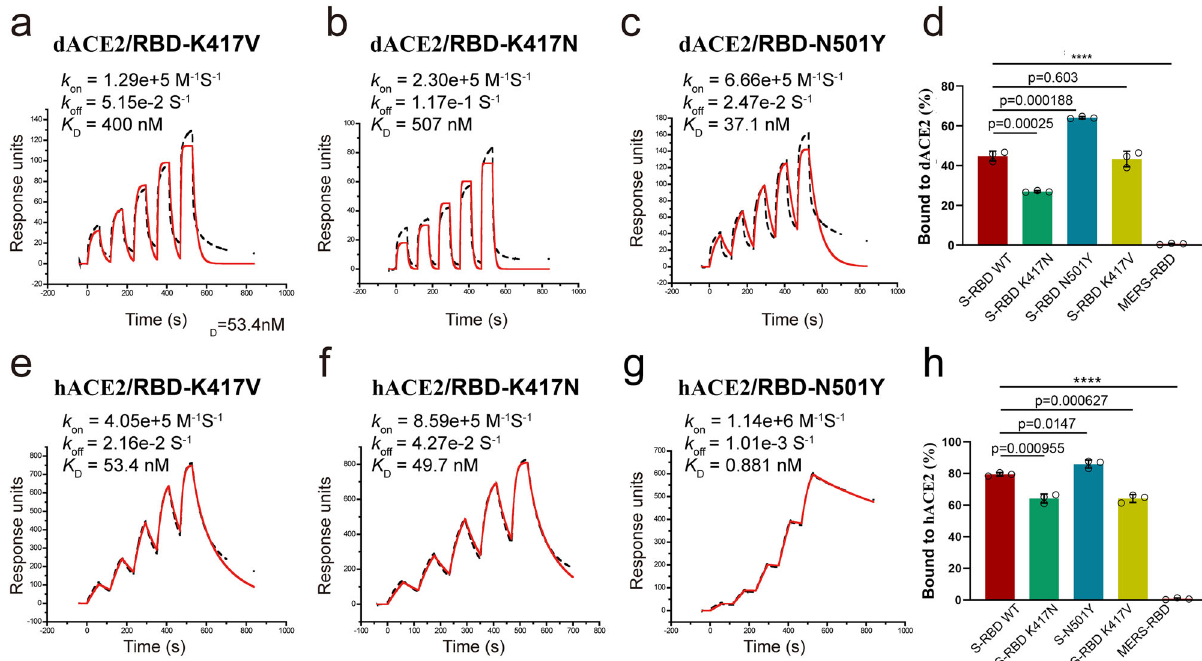
Fig. 4 The binding ability of RBD mutants to both soluble and transmembrane dACE2 and hACE2. a – c SPR sensorgram for RBD interface residue mutants binding to dACE2. e – g RBD interface residue mutants binding to hACE2. The black dashed lines represent the actual data, while the red solid lines represent the fi tted results. The k on , k off , and K D values for each mutant are indicated. d , h Flow cytometry assay for RBD interface residue mutants binding to dACE2 ( d ) and hACE2 ( h ). The Y -axis represents the percentage of the APC + eGFP + cells in the eGFP + cells. Data are presented as mean values ± SD of triplicate cell samples. **** p < 0.0001 vs wt; two-tailed Student ’ s t